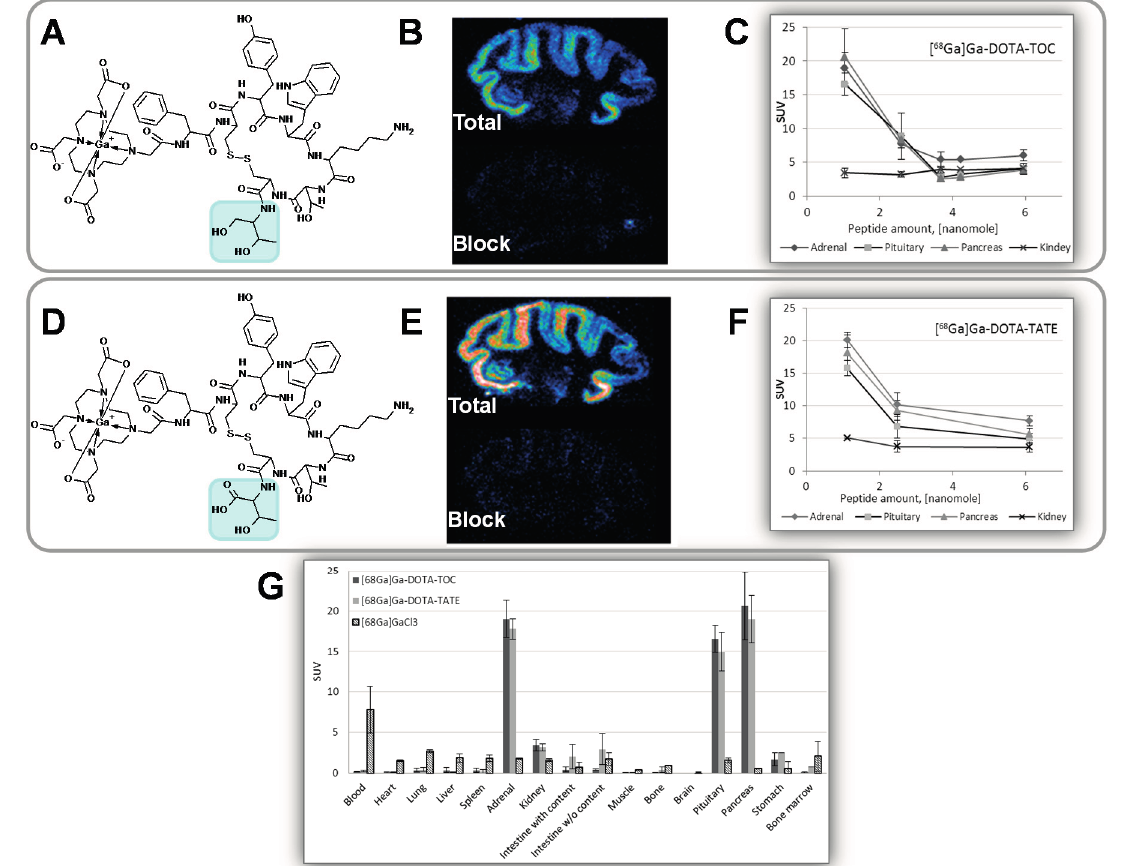
Figure 18. ( A ) Chemical structure of [ 68 Ga]Ga-DOTA-TOC (IC 50 = 2.5 ± 0.5; cell culture); ( B ) Rhesus monkey brain frozen section autoradiography (IC 50 = 23.9 ± 7.9); ( C ) In vivo rat organ distribution for variable injected peptide amount; ( D ) Chemical structure of [ 68 Ga]Ga-DOTA-TATE (IC 50 = 0.2 ± 0.004; cell culture); ( E ) Rhesus monkey brain frozen section autoradiography (IC 50 = 19.4 ± 8.3); ( F ) In vivo rat organ distribution for variable injected peptide amount; ( G ) Rat organ distribution of [ 68 Ga]Ga-DOTA-TOC and [ 68 Ga]Ga- DOTA-TATE 1 h post injection of 1 nmol of the